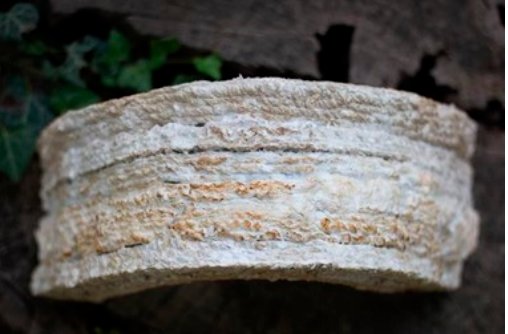
Figure 15. The Bio-welded Arches (Image credit: